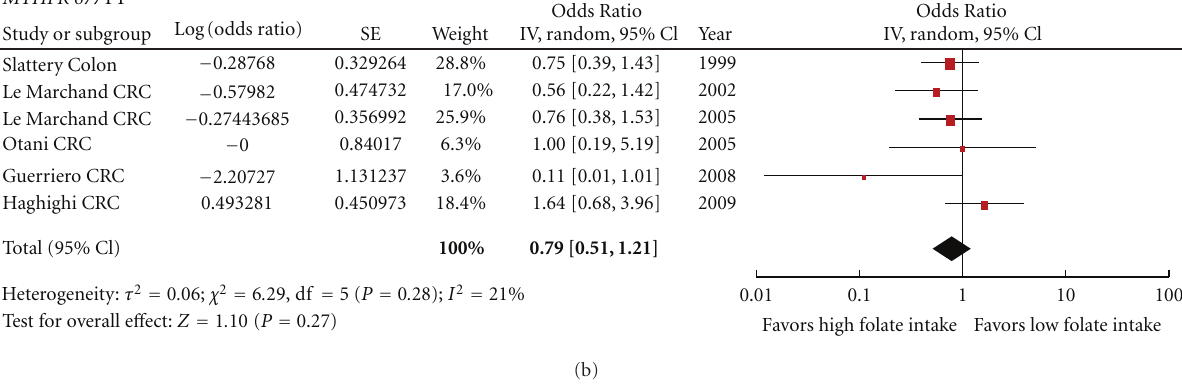
Figure 6: Forest plot of the risk of colorectal cancer comparing high versus low folate intake within each MTHFR C677T polymorphism. Table 3: Subgroup analysis for the MTHFR A1298C